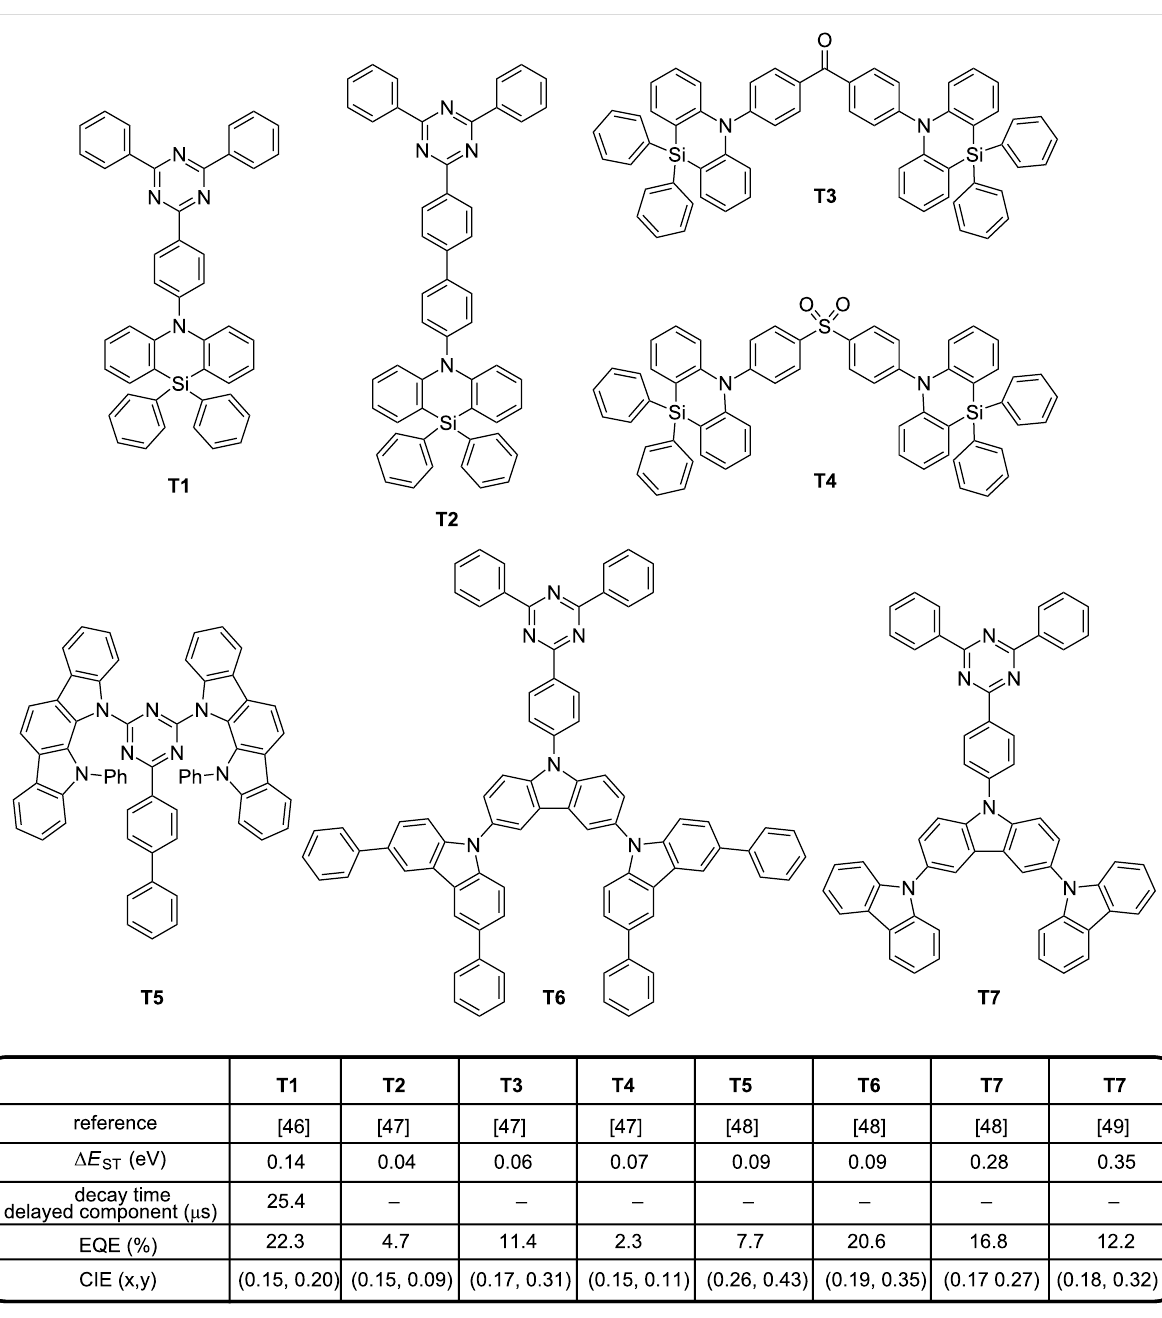
strategy used to connect the donor(s) to triazine. However, contrarily to azasiline that possesses a six-membered central ring, carbazole only possesses a five-membered central ring, in- ducing a deviation of the two adjacent aromatic rings. As a result, carbazole is not capable to induce the same encum- brance as that of azasiline by inducing smaller steric effects and the substitution of the 1,8-positions is often required to main- tain a large dihedral